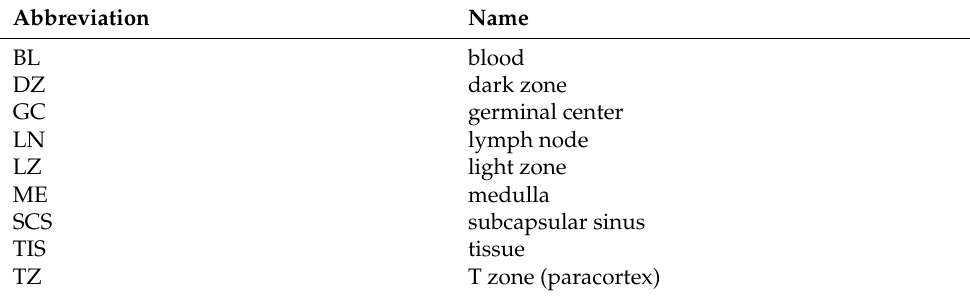
Table 1. Abbreviations for the compartments of the lymph